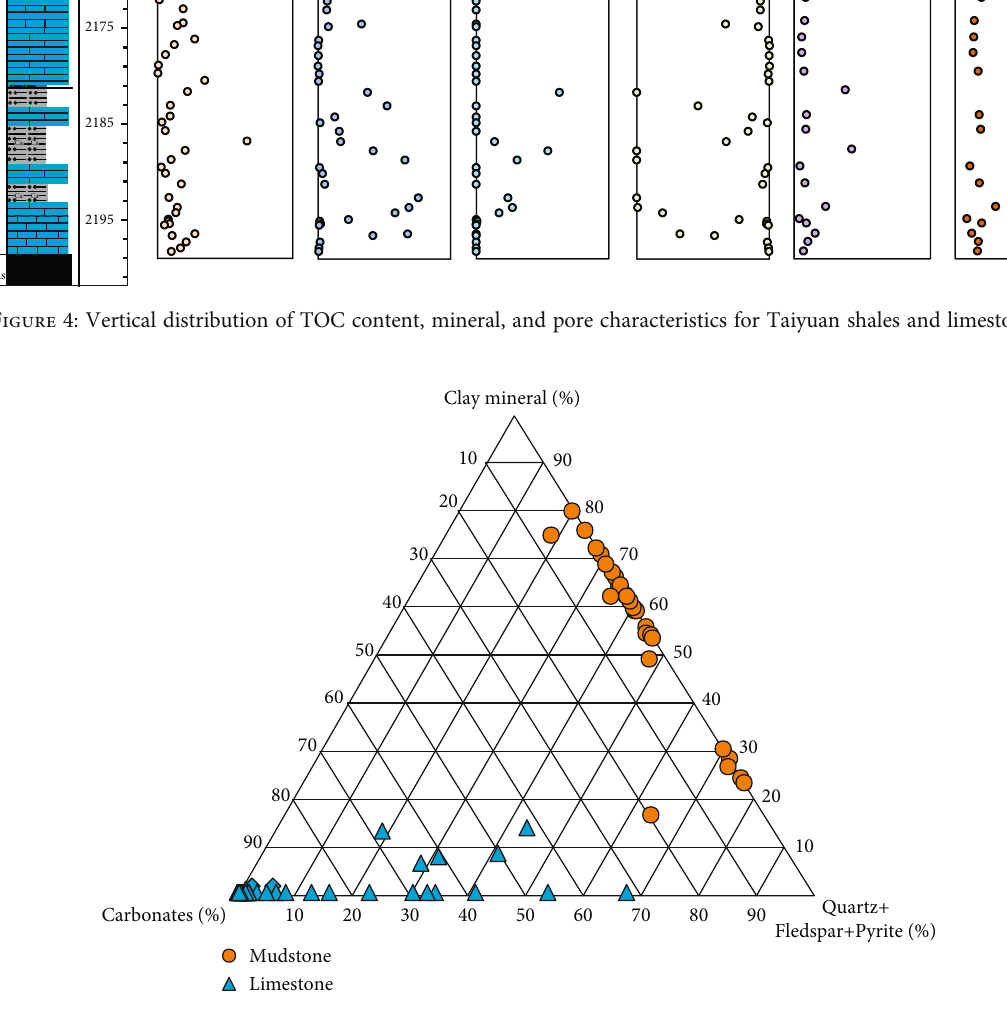
Figure 5: Ternary diagram of the mineralogical compositions of Taiyuan shales and